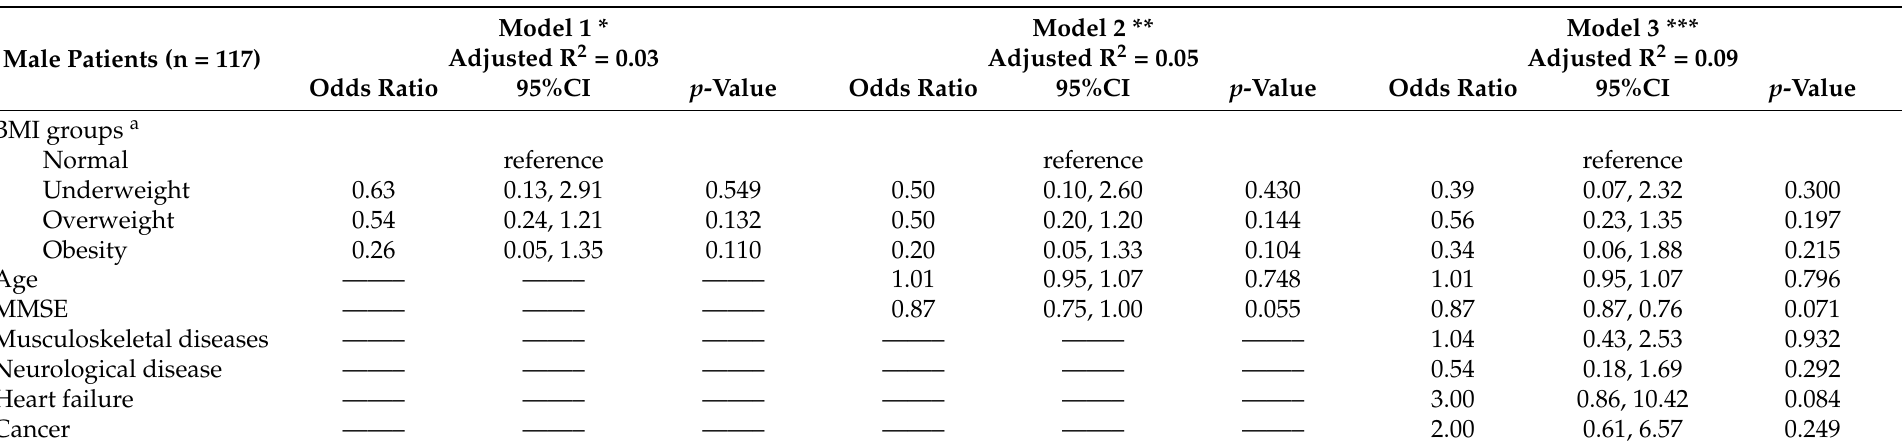
Table 4. Odds ratio for frailty in logistic regression model with normal weight as reference in male